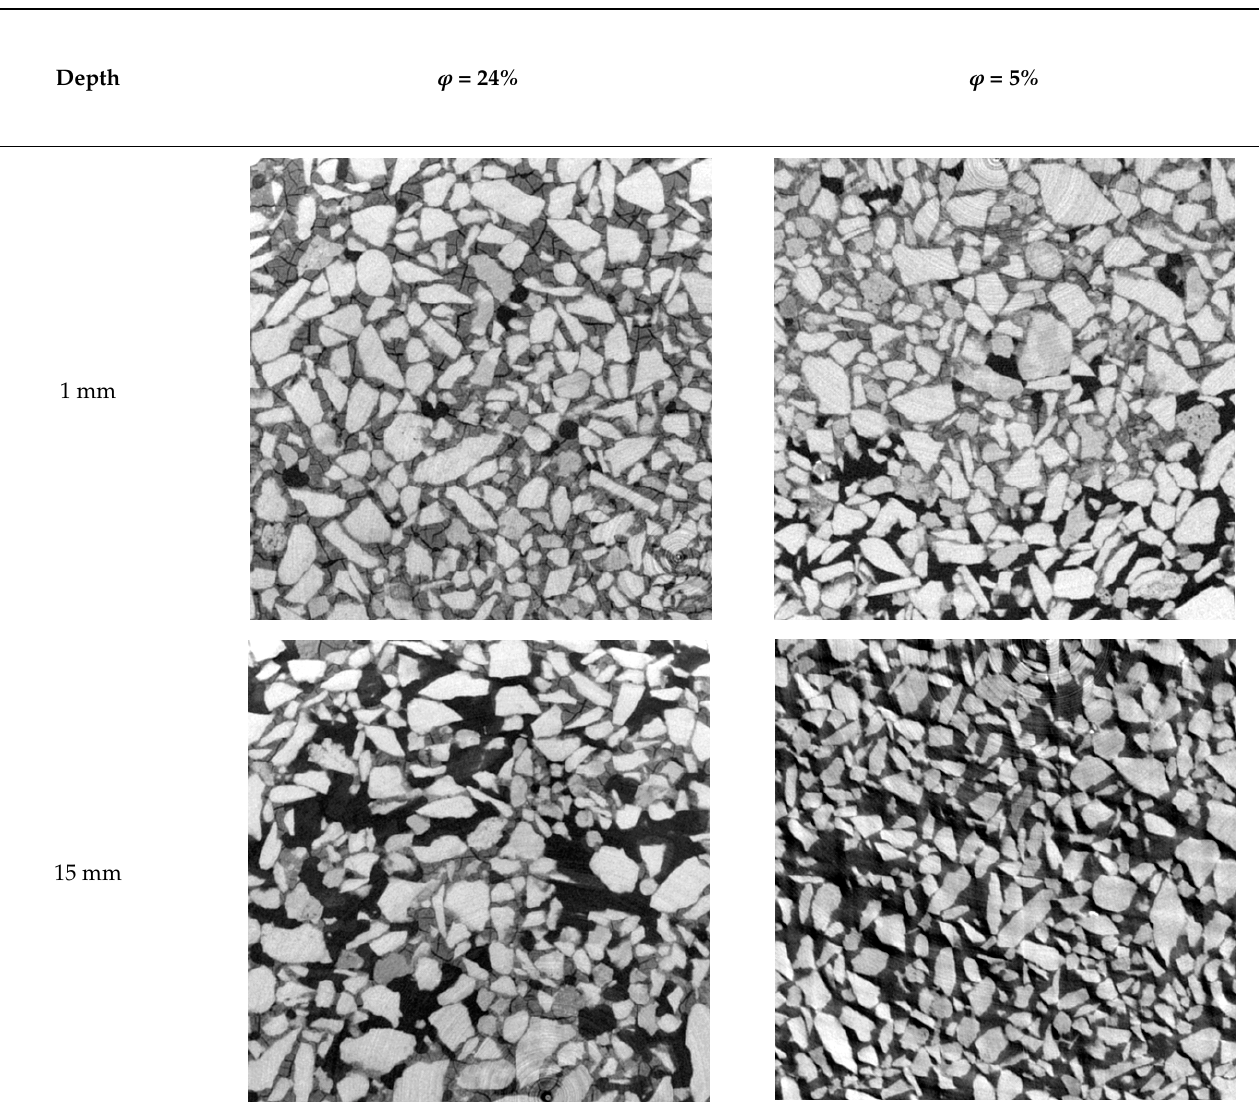
Figure 3. Microtomography image with the identified porosity in red, for 𝜑 = 5% at 1 mm depth. For 𝜑 = 24% , the porosity far from the surface was around 25%, even though it fluc- tuated from 20 to 30% (Figure 4). These strong variations may be due to hand packing. Closer to the top surface, the porosity decreased constantly, down to 2% at the top surface. Indeed, the top surface was identified as the position of the minimum porosity. Given the strong fluctuation of the porosity, it was difficult to define a bottom part where